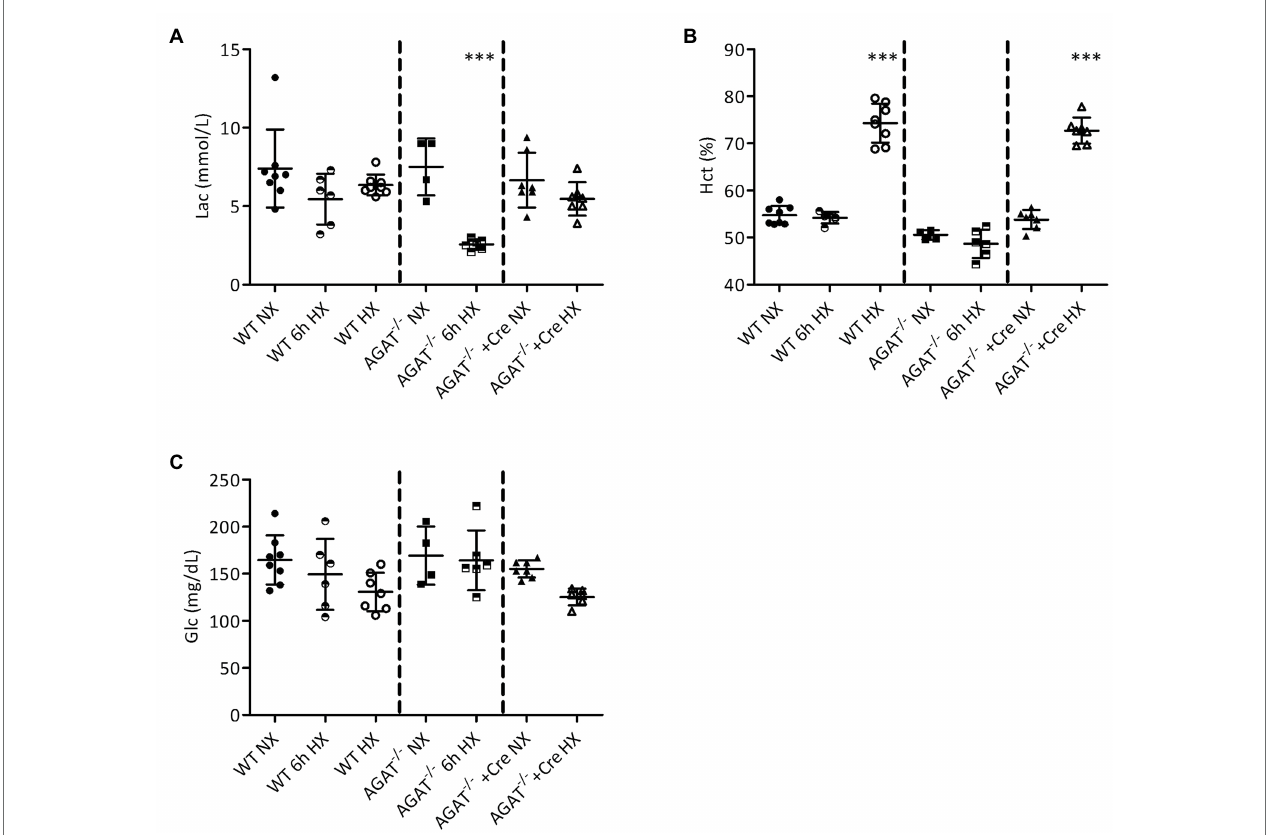
FIGURE 1 | Blood analyses of Agat − / − mice and wild-type (WT) littermates. (A–C) Mean values ± SD from blood gas analyses under normoxia (NX), after 6 h of hypoxia (6 h HX) and after 4 weeks of hypoxia (HX) in unsupplemented and Agat − / − mice supplemented with 1% creatine from weaning (Cre). (A) Lactate